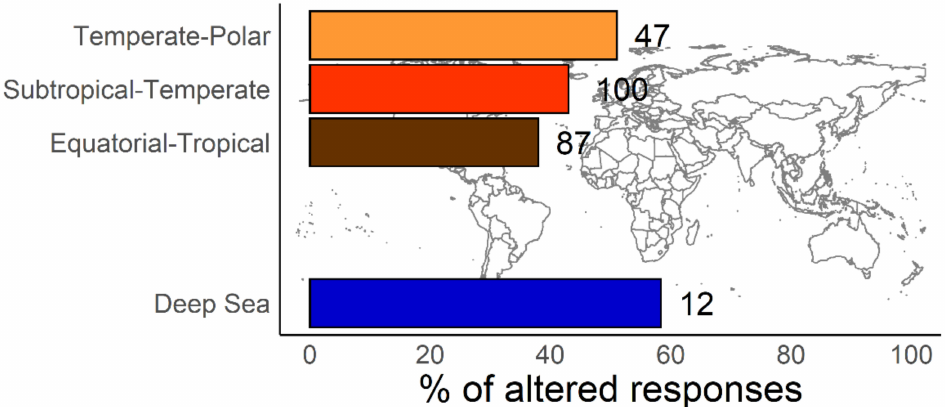
Figure 3. Percentage of altered responses in sea urchins from different latitudinal ranges and the deep sea. On the right of each bar, the number of endpoints per case is